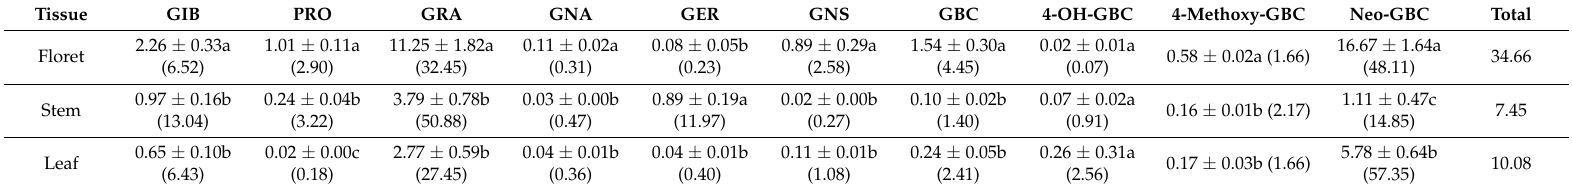
Table 1. Glucosinolate concentrations in different tissues of broccoli ( µ mol/g dry weight,